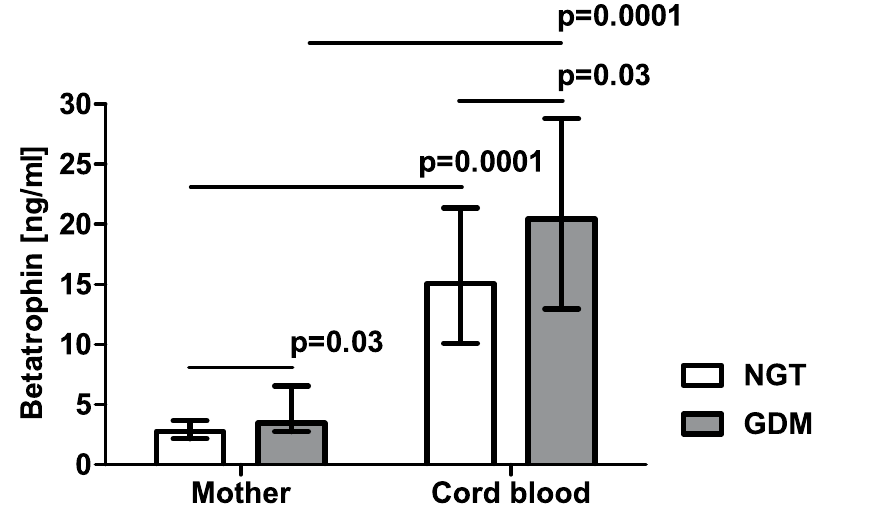
Fig 3. Serum betatrophin concentration in patients with normal glucose tolerance (NGT) and gestational diabetes (GDM) from Group 2; data were analyzed by Mann-Whitney U test and shown as medians with interquartile ranges.